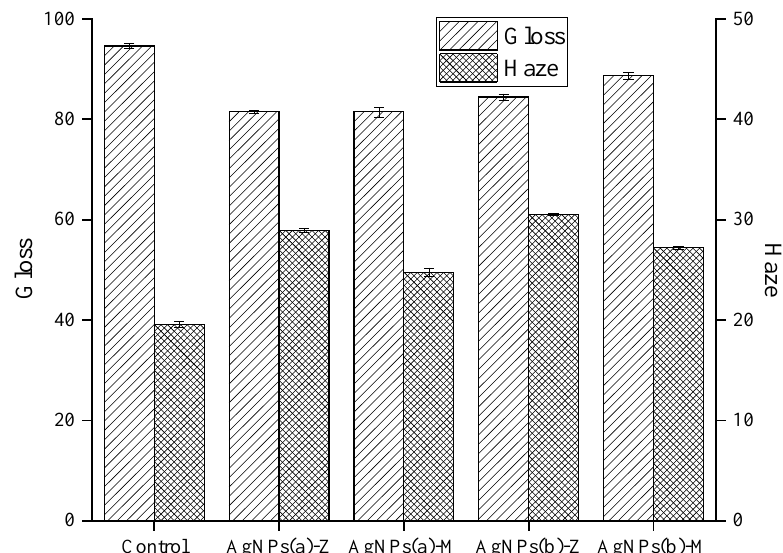
Figure 7. Effects of antimicrobial additives on gloss and haze.